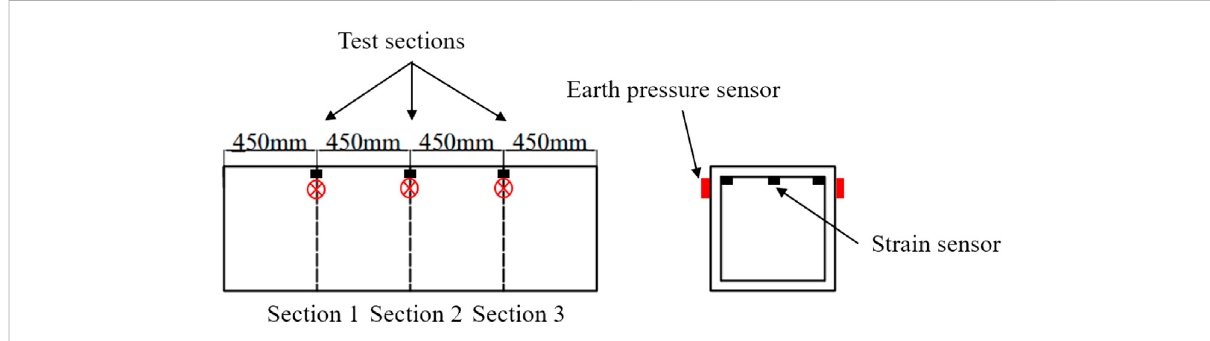
FIGURE 2 Distribution of sensors.